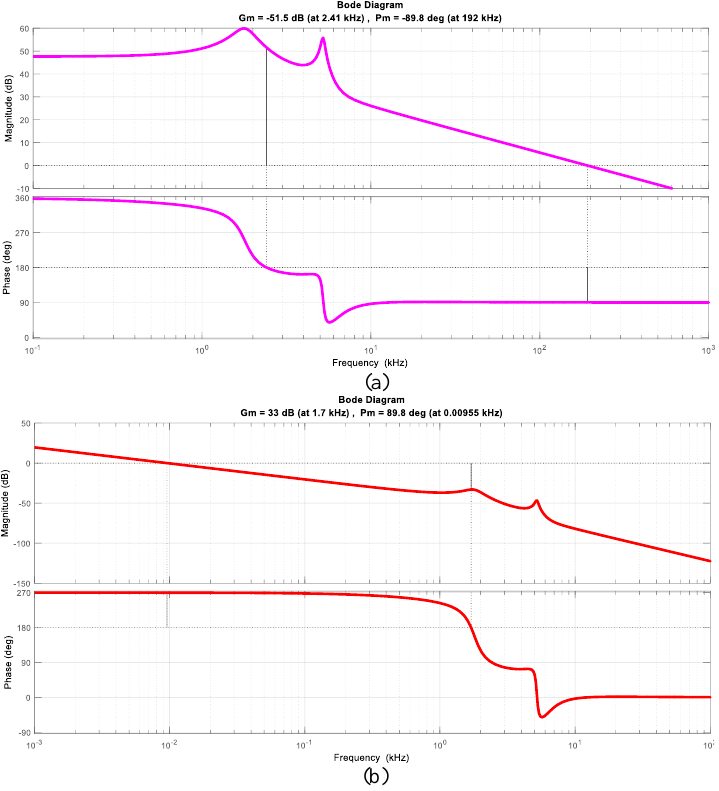
Figure 9. The bode diagram ( a ) before compensating, and ( b ) after